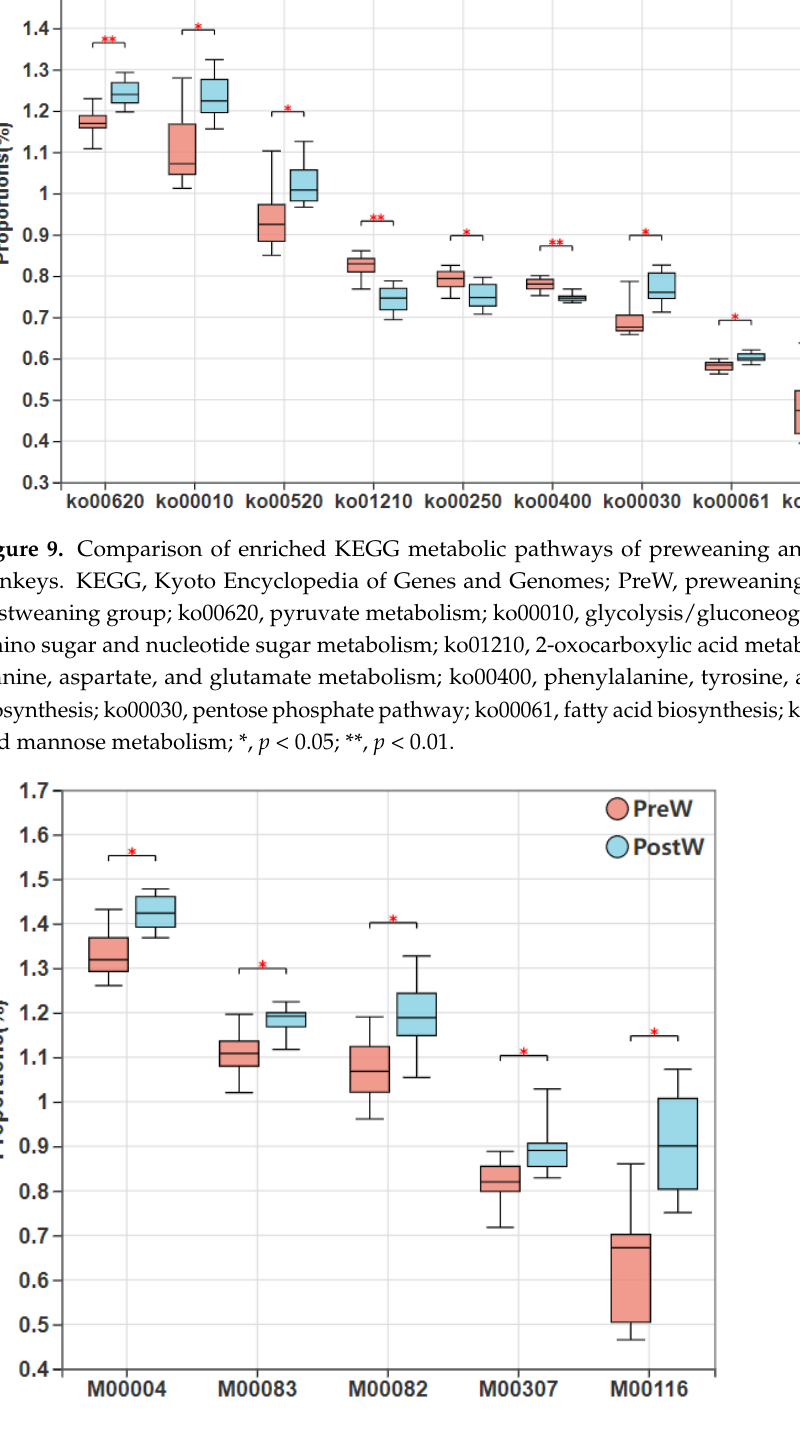
Figure 10. Comparison of enriched KEGG module of preweaning and postweaning donkeys. KEGG, Kyoto Encyclopedia of Genes and Genomes; PreW, preweaning group; PostW, postweaning group; M00004, pentose phosphate pathway (pentose phosphate cycle); M00083, fatty acid biosynthesis (elongation); M00082, fatty acid biosynthesis (initiation); M00307, pyruvate oxidation, pyruvate => acetyl-CoA; M00116, menaquinone biosynthesis, chorismate => menaquinol; *, p <